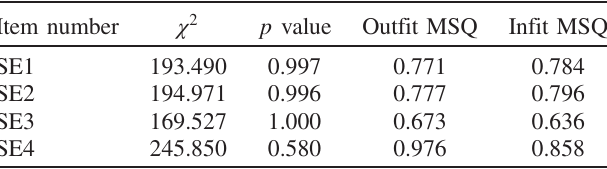
TABLE IV. Item-fit statistics for the questionnaire